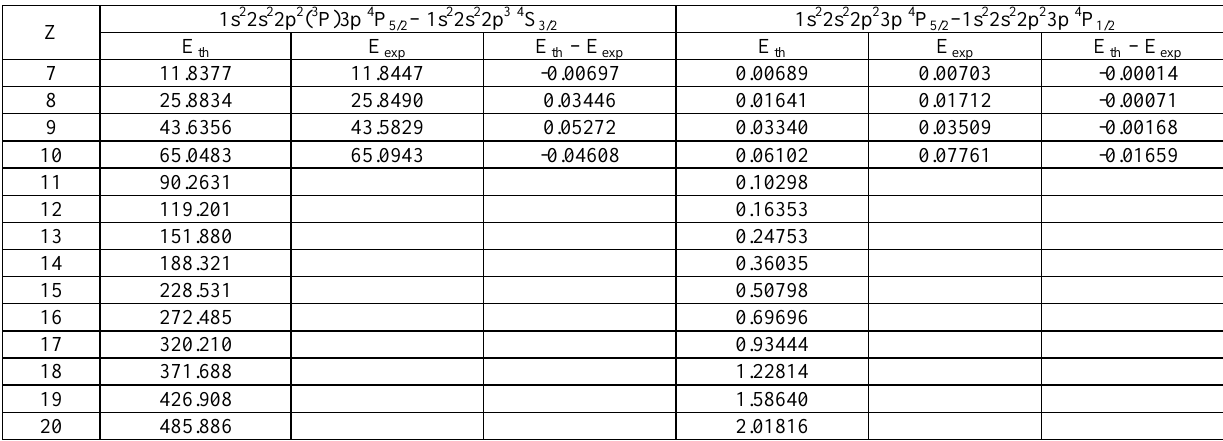
Table 4. Comparison with experiments of the calculated energies (in eV) of 1s 2 2s 2 2p 2 ( 3 P)3p 4 P 5/2 states of nitrogen-like ions and